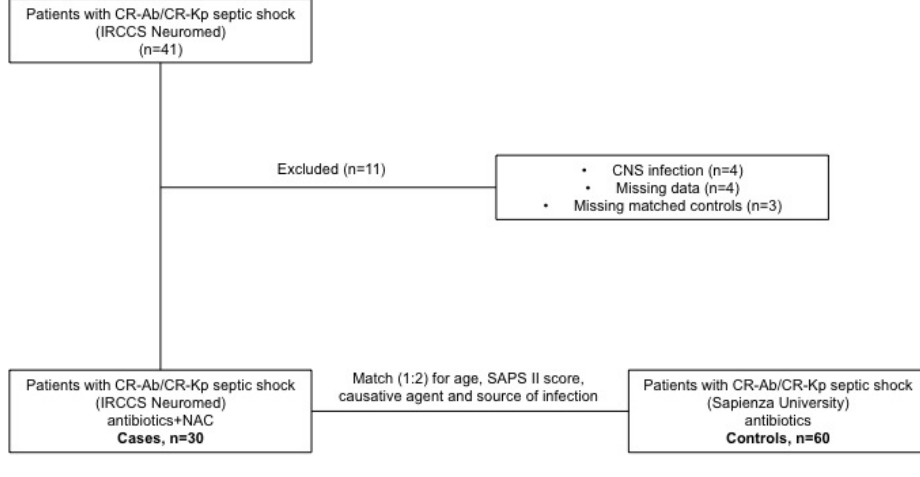
Figure 1. Flow-chart of the study. Mean age was 58.1 and 59.2 years in case and control groups, respectively. 80% of cases and 68.3% of controls were male. SAPS II was 35.3 and 38.6 in cases and controls, respectively. Previous antibiotic therapy was recorded in 63.3% and 48.3% of cases and controls, respectively, whereas a previous CR-Kp or CR-Ab colonization was found in 43.3% and 28.3% of cases and controls, respectively. Length of ICU stay was statistically significant longer in cases than in controls (51.4 vs. 27.8 days, p < 0.001). Study population characteristics are shown in Table